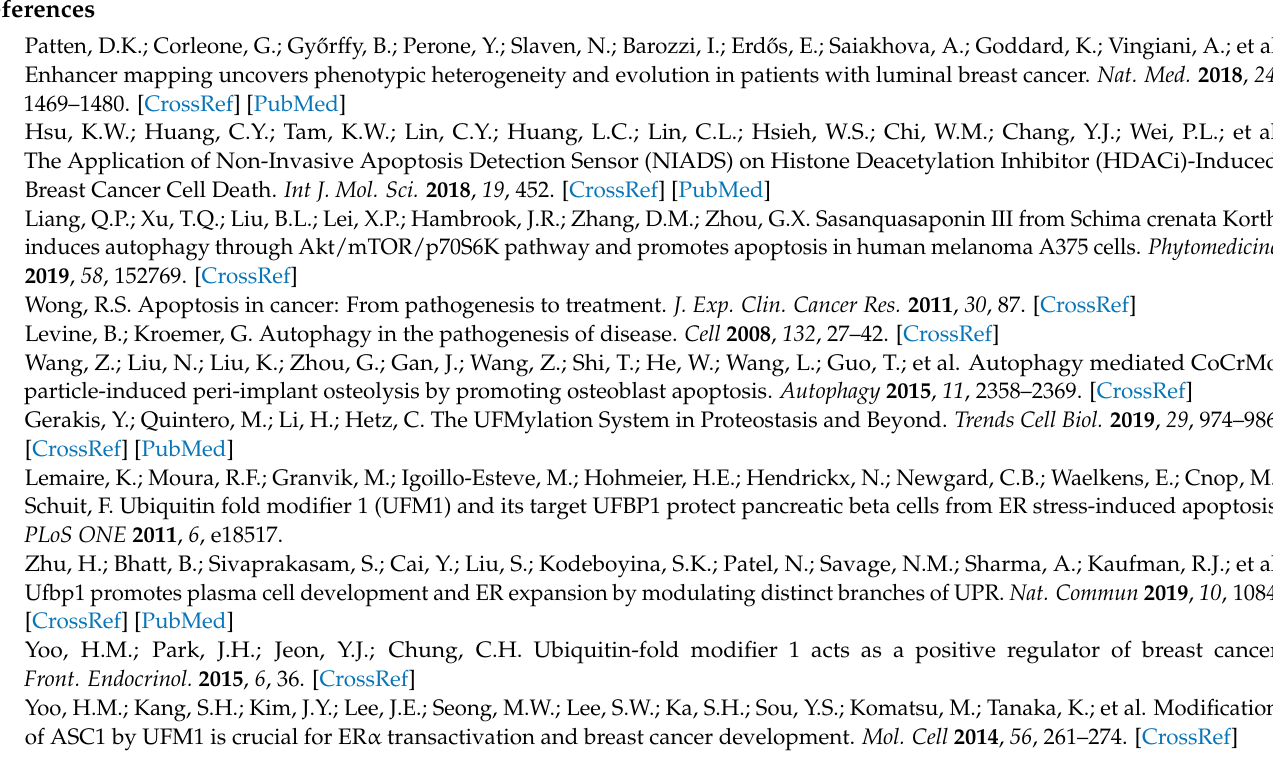
Figure S2. 13 C NMR (100 MHz) spectrum of usenamine A in DMSO- d 6 , Figure S3. 1 H- 1 H COSY spectrum of usenamine A in DMSO- d 6 , Figure S4. HSQC spectrum of usenamine A in DMSO- d 6 , Figure S5. HMBC spectrum of usenamine A in DMSO- d 6 , Figure S6. Effect of usenamine A on the viability of triple-negative breast cancer cells, Figure S7. Apoptosis analyses of MDA-MB-231 cells treated with usenamine A and